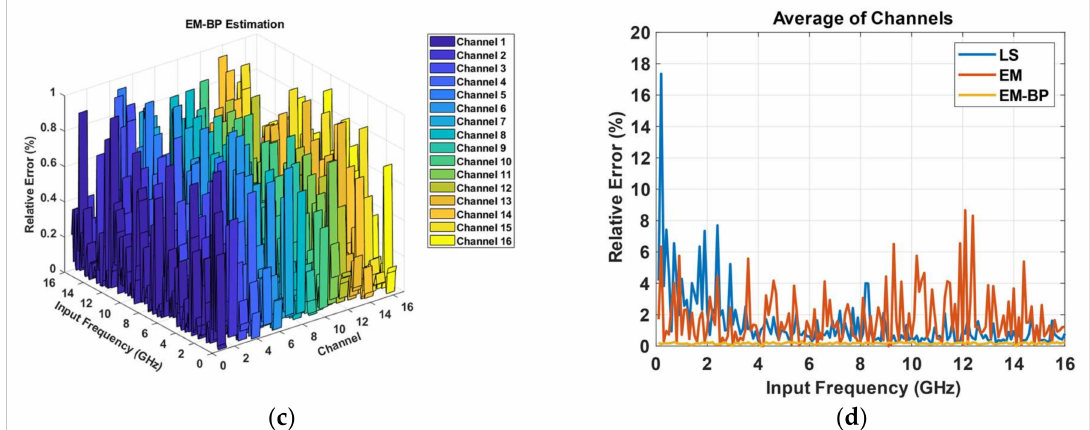
Figure 3. Relative error comparison among LS, EM, and EM-BP methods; the sampling frequency was 40-GS/s. ( a ) Relative error of LS estimation; ( b ) relative error of EM estimation; ( c ) relative error of estimation based on the EM-BP method; ( d ) average results of 16 channels; the relative error of the EM-BP method was the lowest and was below 1%.